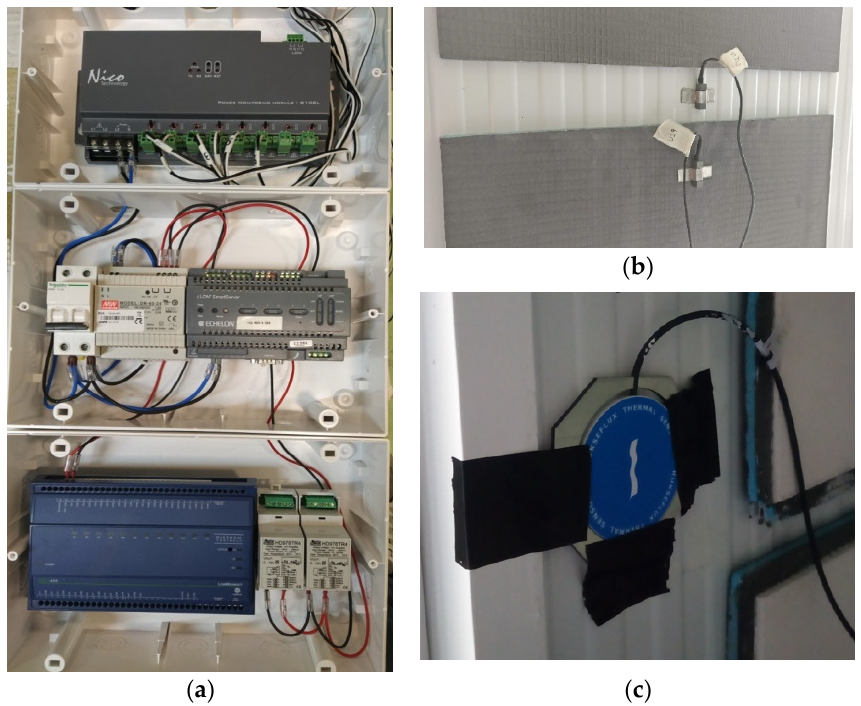
Figure 5. Example views of the main components of the monitoring infrastructure placed inside the test cells: ( a ) electrical cabinet with datalogger, PLC and auxiliary monitoring devices, ( b ) surface temperature probes, ( c ) heat flux meter on an internal wall.